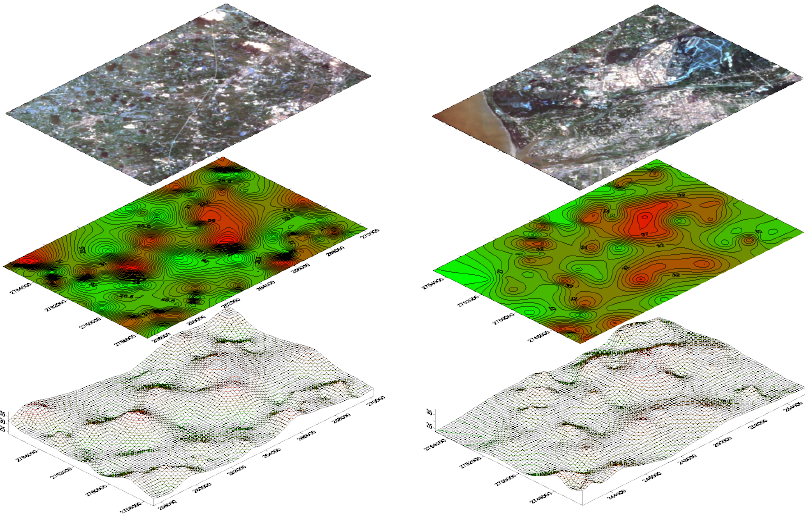
Figure 5. Taoyuan ( Right ) and Hsinchu ( Left ) research areas’ satellite surface images and regional isothermal line maps, May 2003.